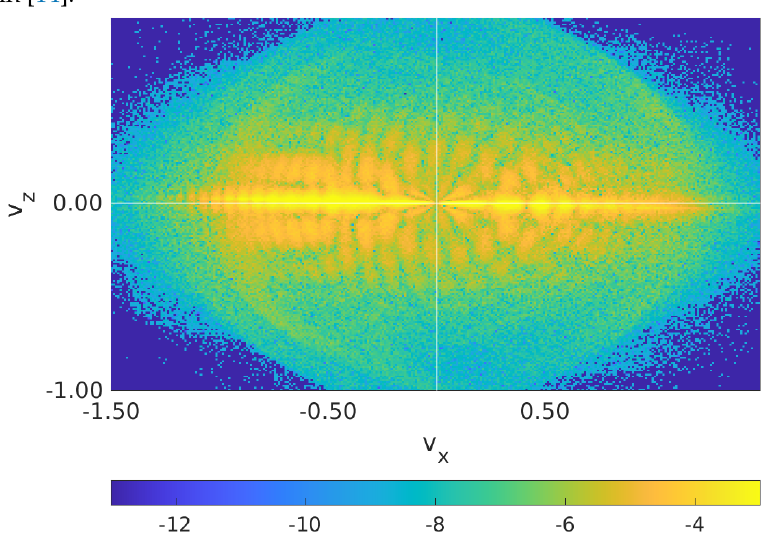
Figure 2. Simulated 2D photoelectron momentum distribution (PMD) when the ionization ratio q = 0.6 (Equation (12)) and carrier envelope phase φ = 0. In this simulation, a six-cycle, 800-nm laser pulse with peak intensity I = 1.3 · 10 14 W/cm 2 is incident upon a neutral N 2 molecule tilted 45 degrees with respect to the polarization direction. When q = 0.6, electrons are ionized at the upfield atom four times more often than the downfield atom. The color bar is on a logarithmic scale with arbitrary